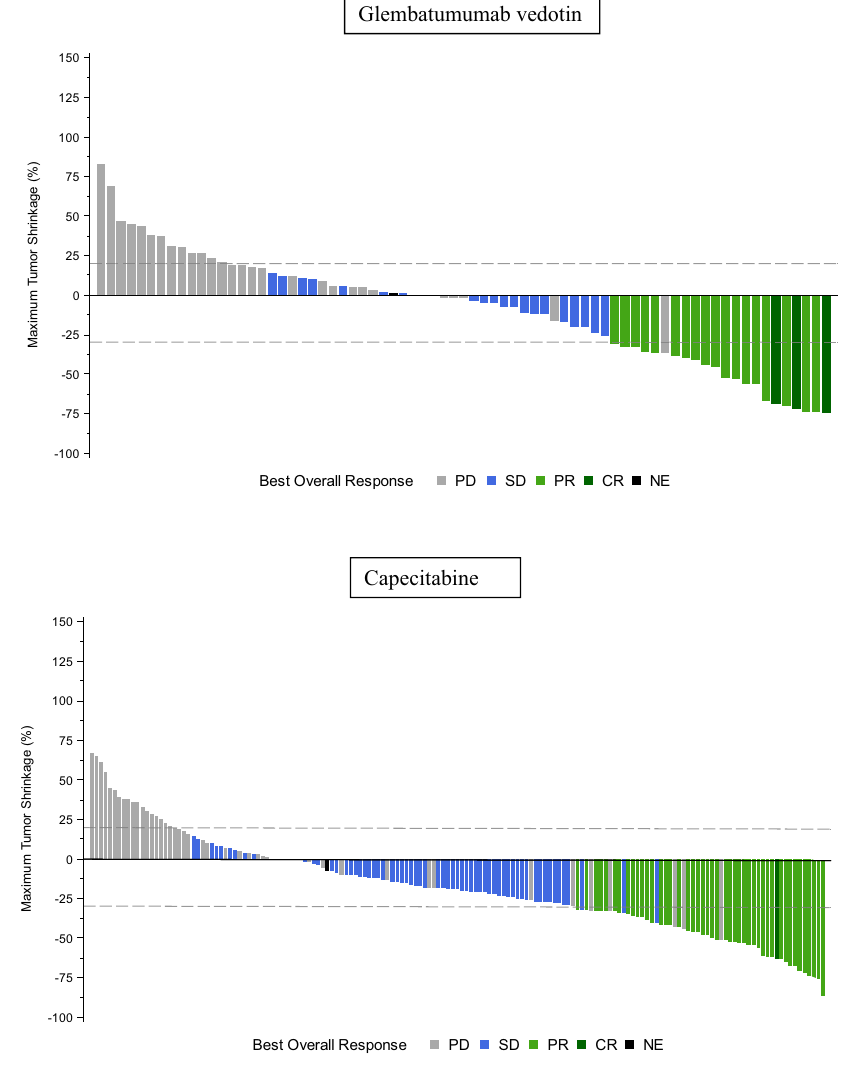
Fig. 3 Maximum tumor shrinkage. Maximum percent tumor shrinkage is shown for patients with evaluable post-treatment measurements of RECIST 1.1 target lesions. Best overall response was determined by RECIST 1.1 criteria 33 by Independent Review Committee. For the measurable disease population (including 15 patients in the glembatumumab arm and 11 patients in the capecitabine arm who are excluded from the waterfall plot due to lack of complete post-treatment assessment of all RECIST 1.1 target lesions), the proportion of patients with any tumor shrinkage was 113/179 (63%) in the glembatumumab vedotin arm and 39/100 (39%) in the capecitabine